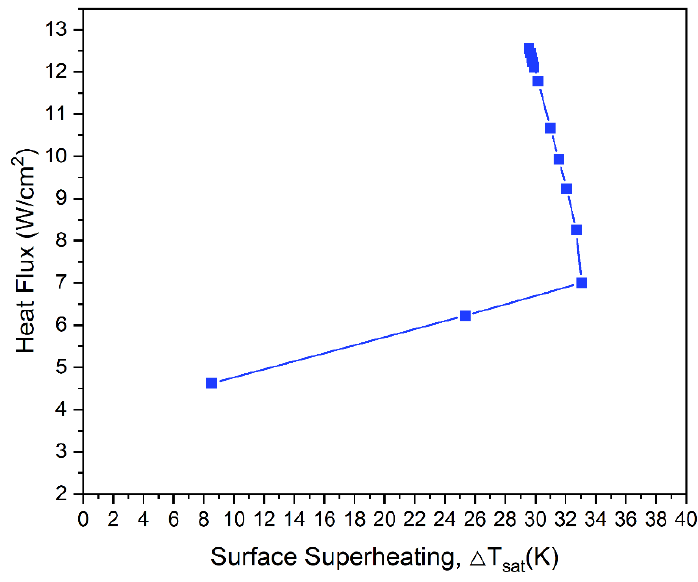
Figure 7. CPU surface q w - Δ T sat boiling curve.